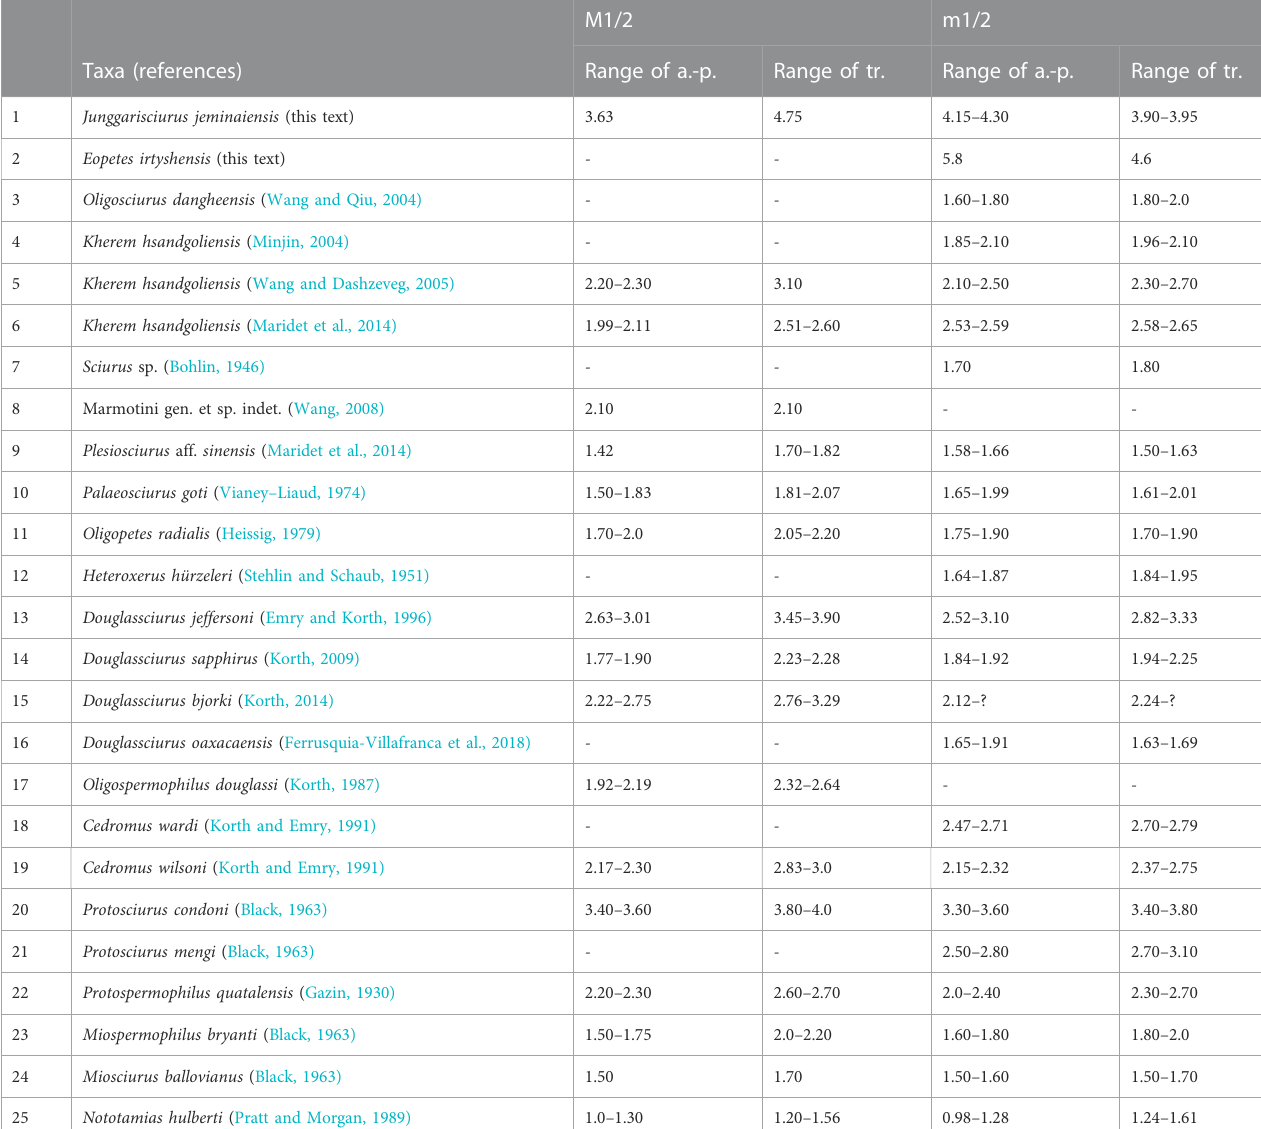
TABLE 1 Measurements (in mm) of M1/2s and m1/2s of late Eocene-Oligocene sciurids. a.-p., anteroposterior length; tr., maximum transverse width. Measurements of taxa 2 – 10 and 12 – 21 derive from the references listed in this table, and those of taxon 11 are estimated from the illustration by Stehlin and Schaub (1951, p. 201). All sources are in the